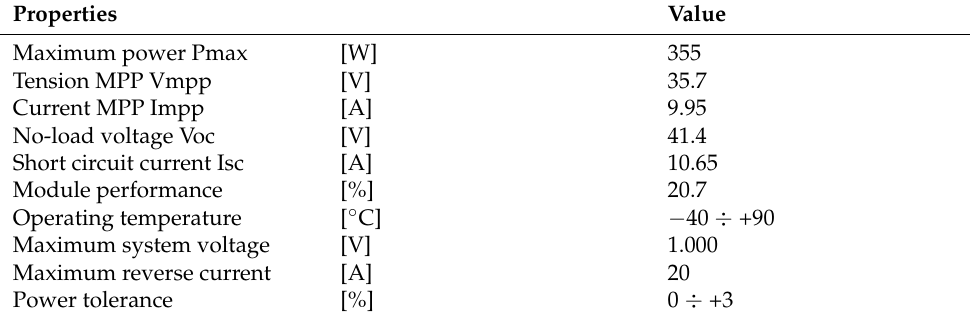
Table 5. Electrical properties (STC) of PV panels.